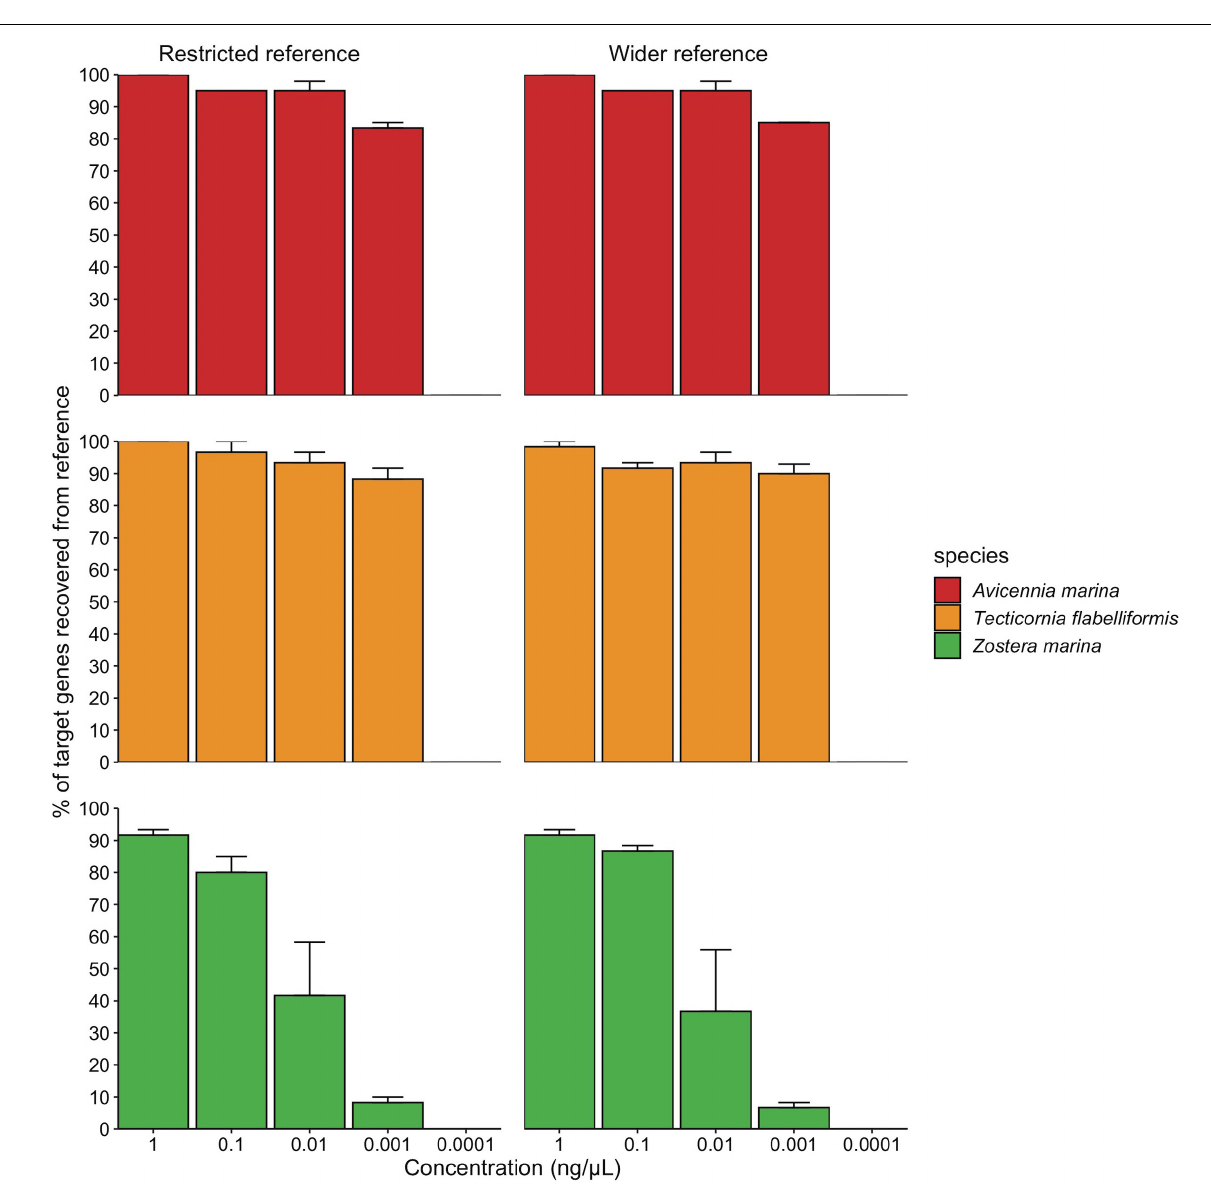
FIGURE 2 | Minimum detection threshold of the targeted capture approach using artificial plant DNA mixtures. All species are in the same mixture but are graphed separately. Concentration reflects the total concentration of the three species mixture, where each species was added in the same volume with a different starting concentration. Restricted and wider reference libraries refer to the different reference databases used in the mapping